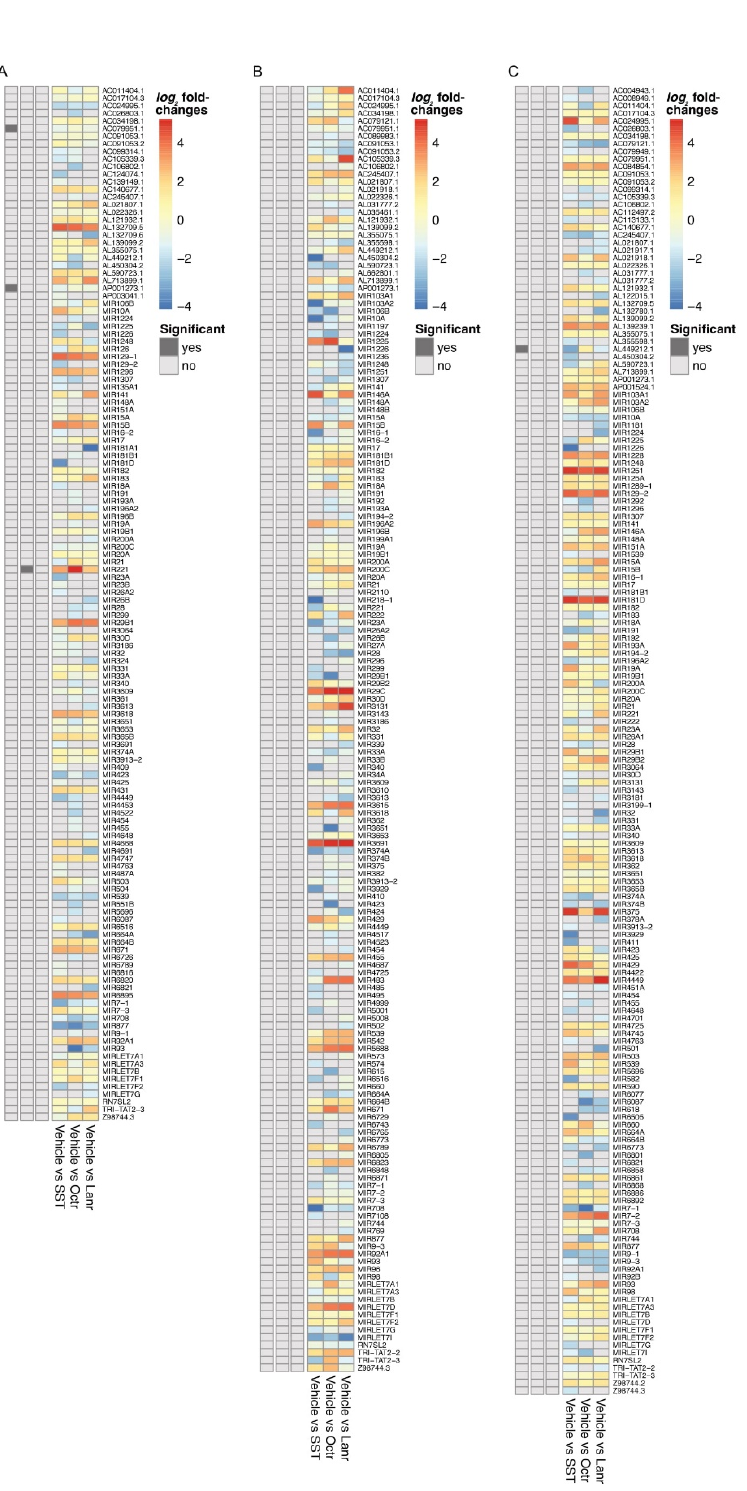
Figure 4. miRNA sequencing in BON ( A ), QGP ( B ), or NT-3 ( C ) cells treated with either vehicle, SST, OCT, or LAN. The heatmaps show log 2 fold changes as estimated by DESeq2. Values above 0 (orange/red colors) denote miRNAs upregulated in the vehicle (no treatment) group compared to the treatment group. In contrast, values below 0 (blue colors) represent those upregulated miRNAs in the treatment group. Grey cells indicate that the miRNA was not found (missing values). The left columns show p -values below 0.1 (dark grey, considered significant) or above 0.1 (light grey, considered non-significant).